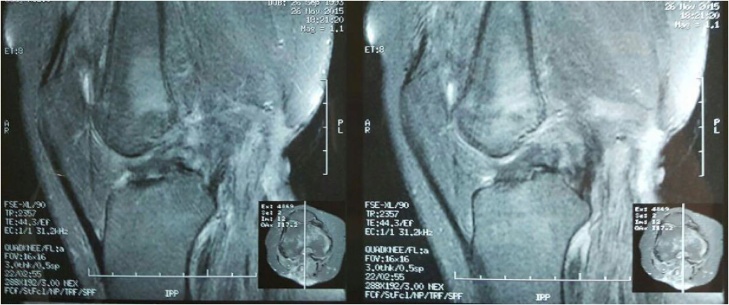
MRI T1-weighted.